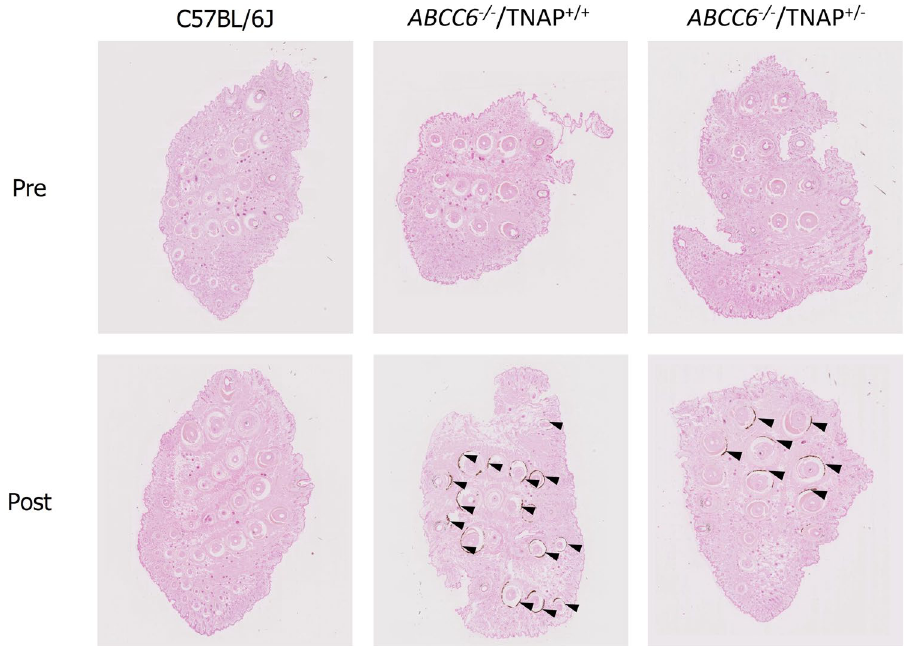
Figure 6. Histological analysis with Von Kossa staining showing calcification of vibrissae in ABCC6 -/- /TNAP +/+ mice, ABCC6 -/- /TNAP +/- mice, and control C57BL/6J mice pre- and postacceleration diet. TNAP, tissue- nonspecific alkaline